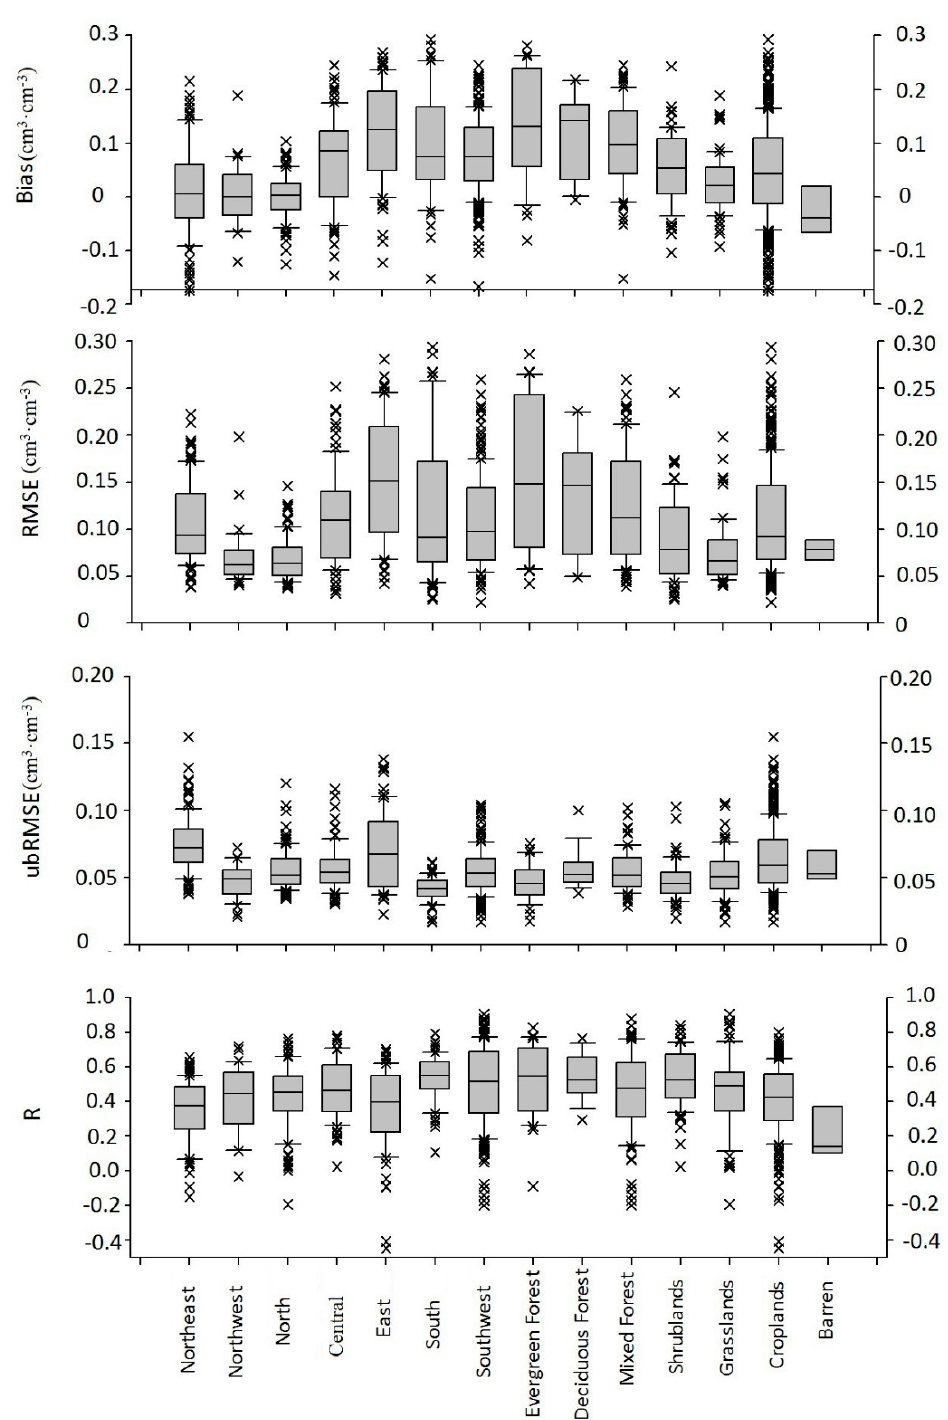
Figure 4. Evaluation of SMAP soil moisture retrievals relative to in situ soil moisture observations based on original data over the different land cover types and geographical zones in continental China. The presented data are the median (the horizontal line inside each box), 1st quantile Q1, and 3rd quantile Q3 (the bottom and top of the box, respectively), and the 90th and 10th percentiles (the whiskers, i.e., error bars, above and below the box).